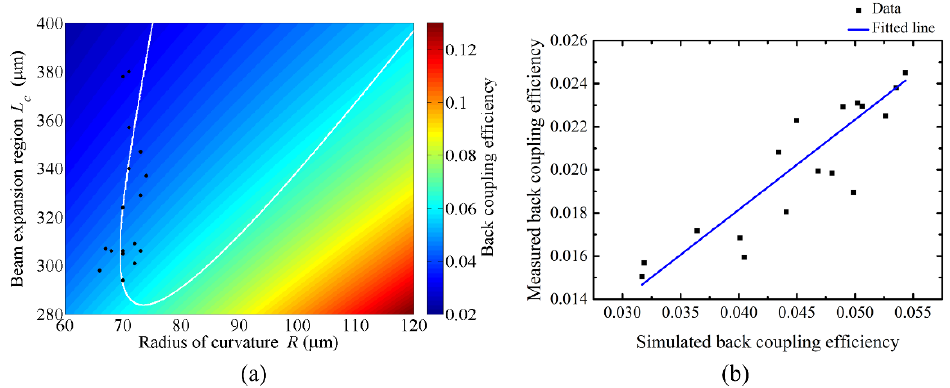
Figure 8. Back-coupling efficiency of a LOF. ( a ) Simulated and color-coded in terms of L c and R . The black dots represent the fabrication parameters measured with 17 fabricated LOFs. The white contour represents the various combinations for having a working distance of 380 µ m. ( b ) Measured and compared with simulated ones. The blue solid line is a fitted line.